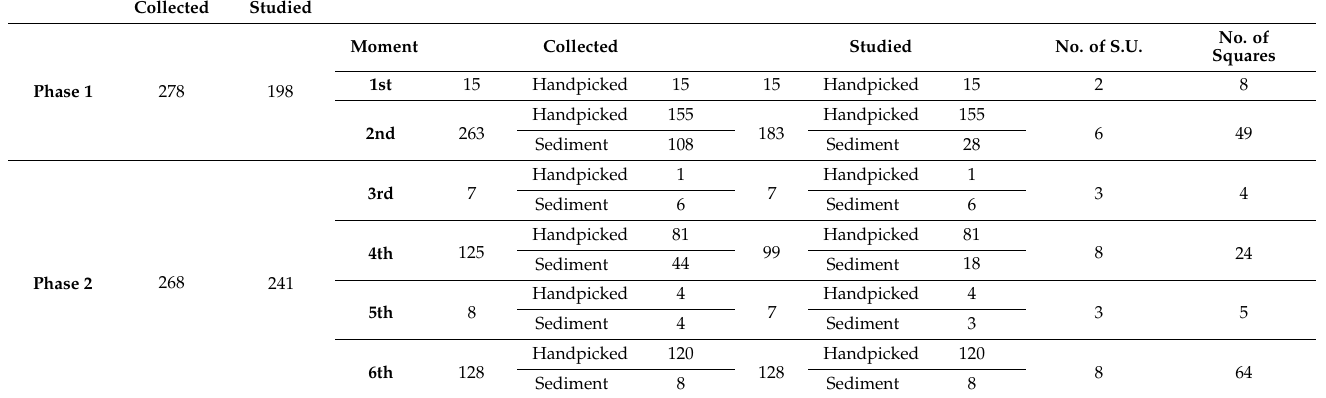
Table 2. Overview of the sampling and recovery strategies applied by phase and moment (detailed data in Table